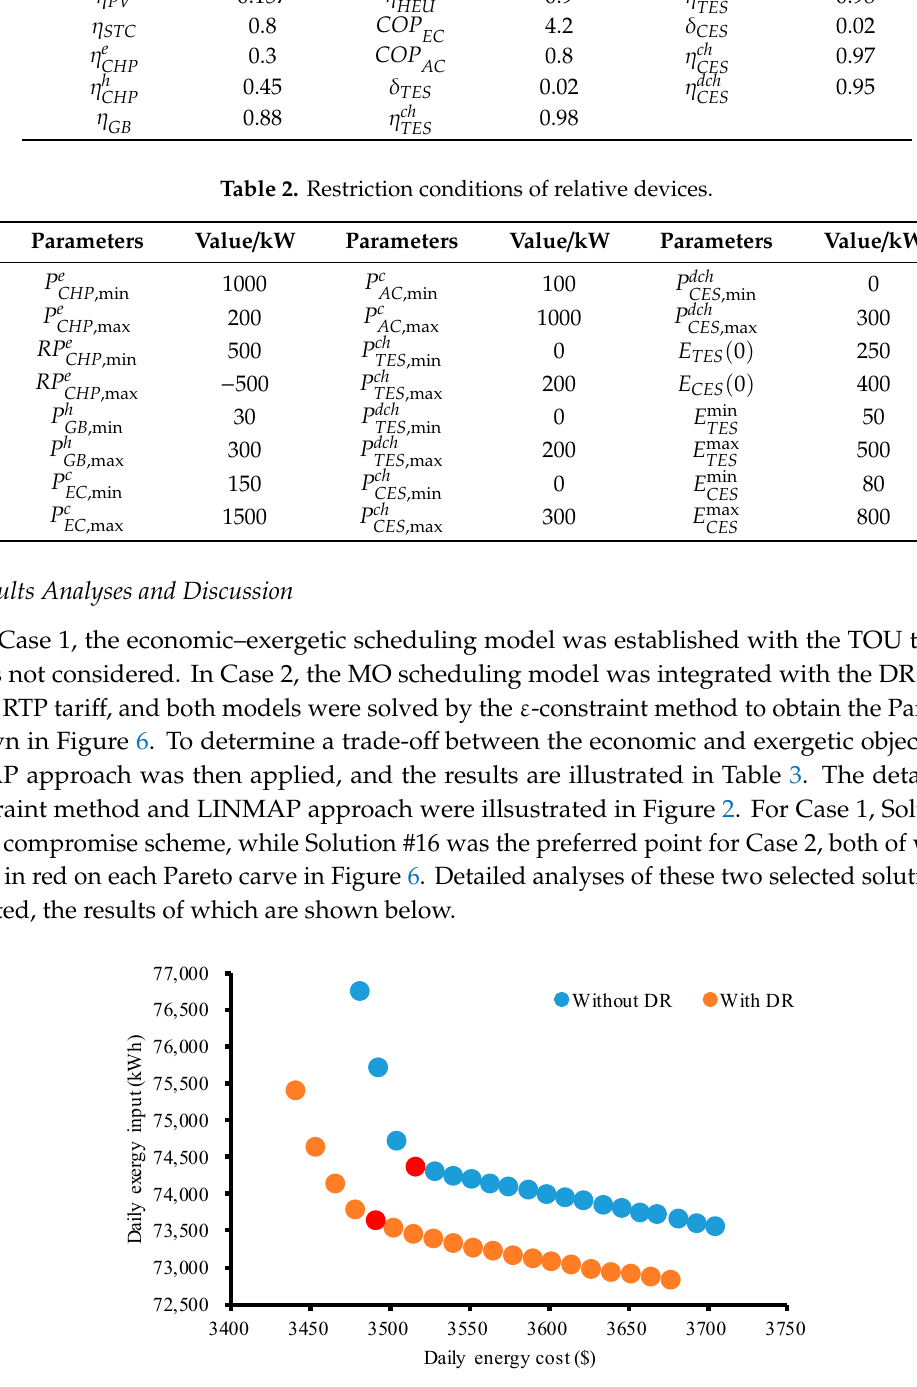
Table 2. Restriction conditions of relative devices.